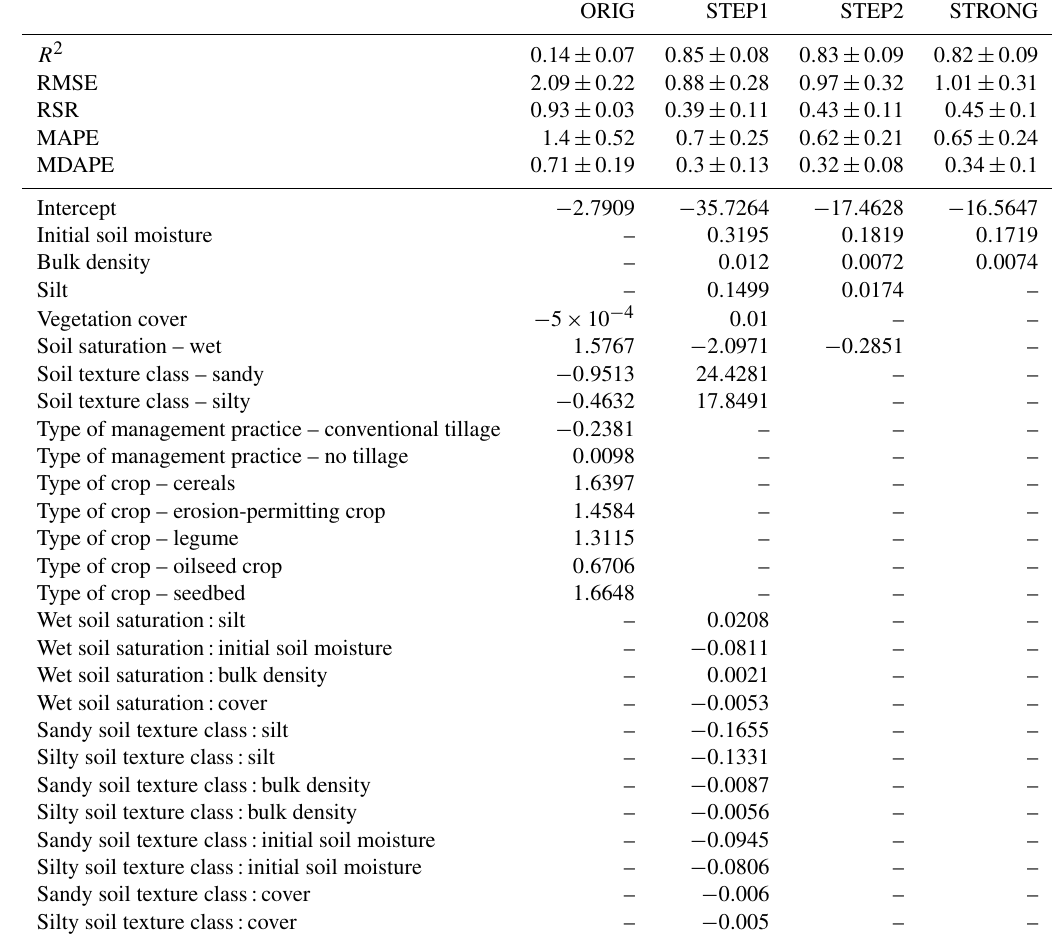
Table 4. Linear mixed-effect models for skinfactor prediction: model evaluation based on the validation dataset using common statistical indicators, model variables, and their